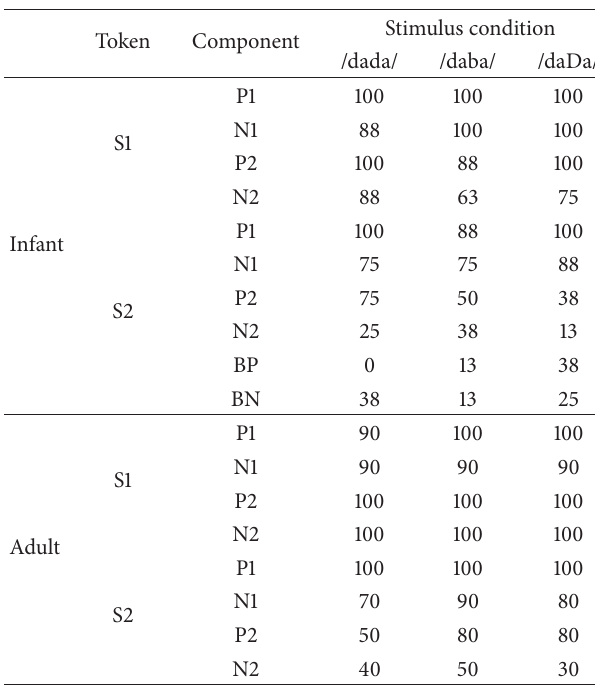
Table1:Percentageofresponsespresentforeachstimuluscondition for infant ( 𝑁 = 8 ) and adult ( 𝑁 = 10 ) participants. The terms “BP”and“BN”denoted“broadpositive”and“broadnegative”peaks, respectively.